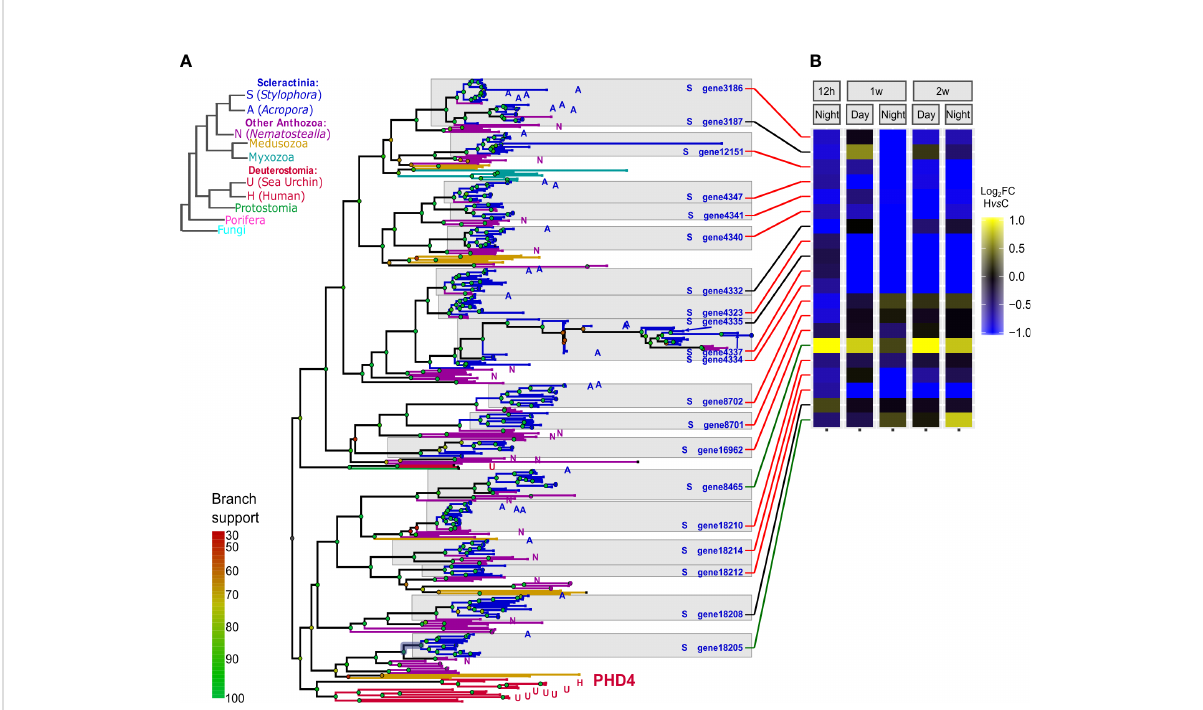
FIGURE 4 Functional and protein-structure conservation of PHD4 gene family in metazoa and cnidaria. (A) Gene tree representation of the PHD4 gene family. This family includes the human PHD4. Left: Metazoan phylogenetic species-tree representing evolution of major species clades. Representative species are symbolled A/S/N/H to denote: Acropora , Stylophora , Nematostella , and human genes; Right: Gene tree representation of the PHD4 gene family in metazoa and fungi, with ~50 metazoa species represented. Leaf colors match the species-tree clade colors. Grey boxes indicate S. pistillata orthologs (Data S6). (B) A heatmap representation of S . pistillata genes H vs C log 2 fold changes of PHD4 orthologs in each time-point (values lower than -1 or higher than 1 are color-coded as maximum values). S. pistillata genes have the same order as in the gene tree. Connecting lines in red/green correspond to signi fi cantly down/up-regulated genes, respectively. Connecting lines in black correspond to not signi fi